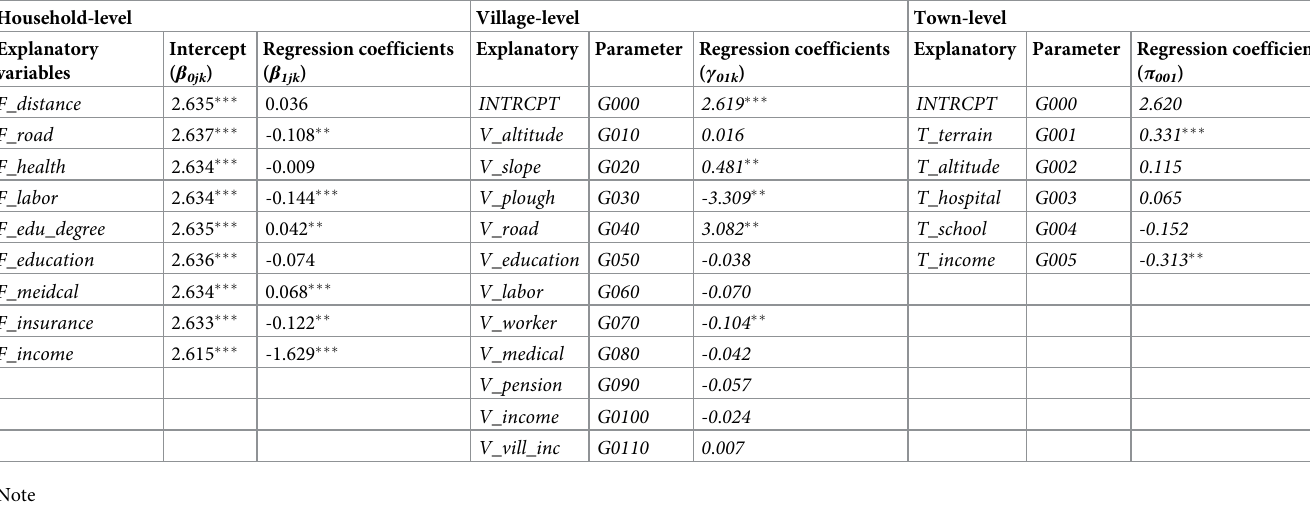
Table 6. Factors affecting the poverty level of poor